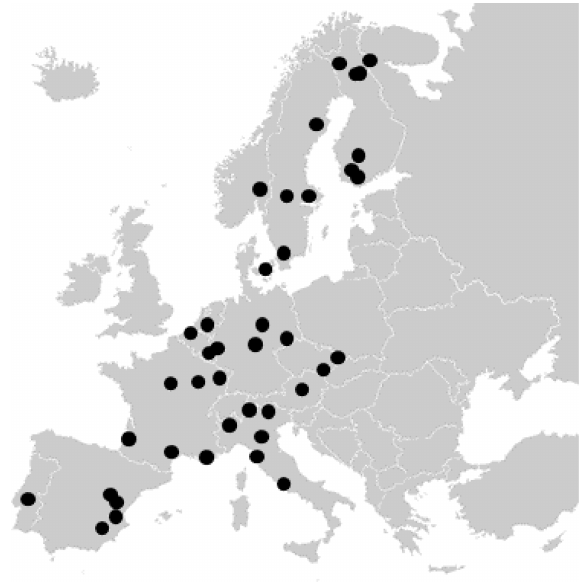
Figure 1. Distribution of study sites across Europe; for further de- tails, refer to Table